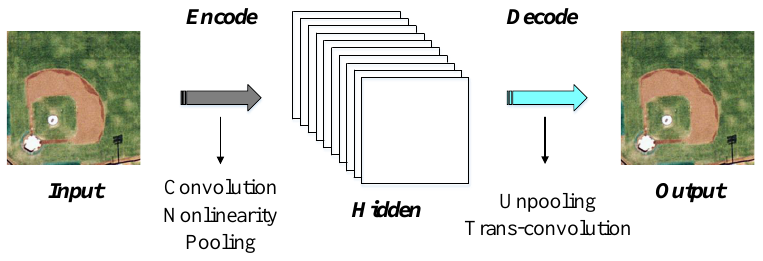
Figure 5. Framework of a convolutional